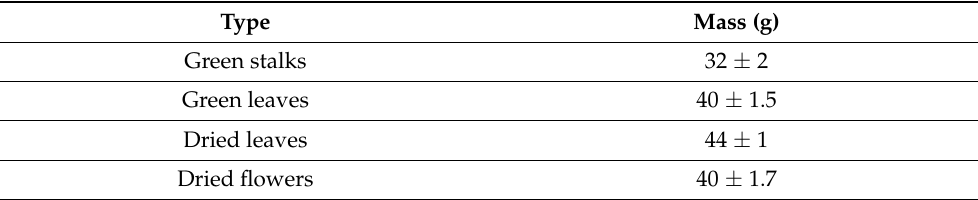
Table 1. Mass of